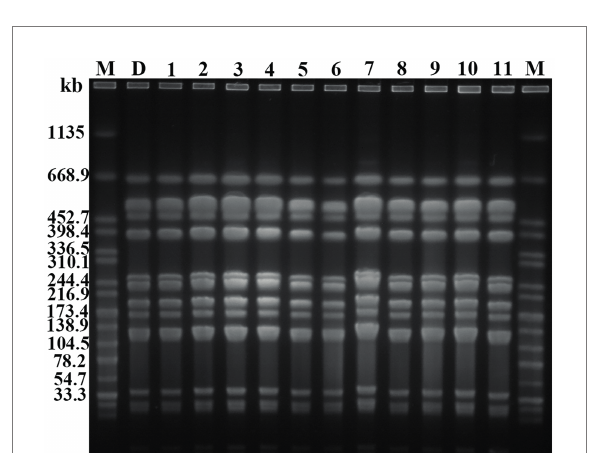
FIGURE 5 Genome atlas of the target strains by PFGE. “M” represents the marker: Salmonella enterica serotype Braenderup H9812, D: DY1928, 1: m1-1.1d, 2: m3-2.1d, 3: m4-1.1d, 4: m1-1.3d, 5: m2- 1.3d, 6: m4-1.3d, 7: m2-1.5d, 8: m4-1.5d, 9: m1-1.7d, 10: m2- 1.7d, 11: m4-1.7d (“m” represents mouse, “d” represents day. e.g., m1-1.1d represents the first strain isolated from the first mouse of DY1928 group on day